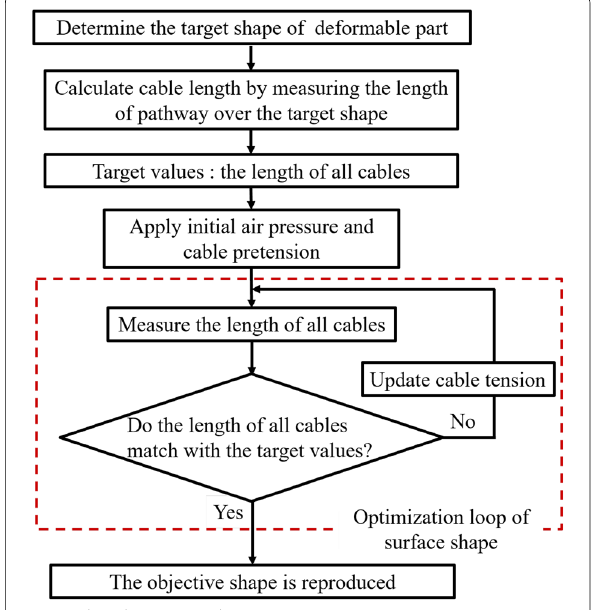
Fig. 4 Skin‑shape reproduction process